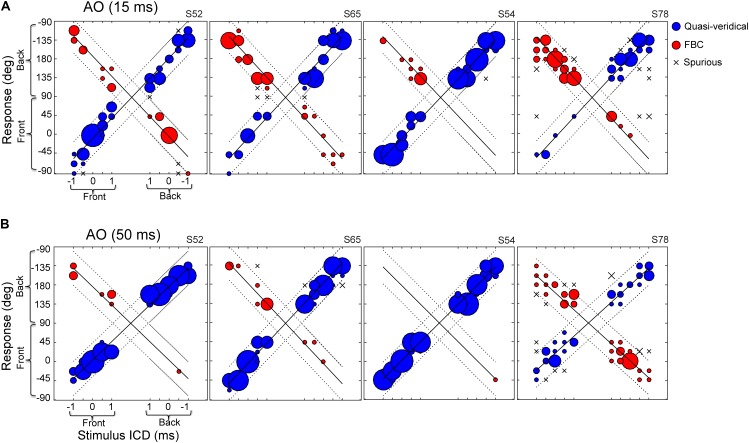
Stereo localization in front and rear space by four exemplar subjects in the AO condition. (A) Results for 15-ms noise burst. (B) Results for 50-ms noise burst. The left–right direction of a perceived sound source was altered by increasing/decreasing the inter-channel delay (ICD from –1 to 1 ms) between two loudspeaker signals. On the each panel, the left half shows front stimuli and the right half shows rear stimuli; the bottom half shows frontal response (–90 to 90°) and top half shows rear response (91 to –91°). See Figure 2 for the graphic layout of the setup. The size of a symbol is proportional to the percent response for a given stimulus. Regression lines were fit to the data using an iterative regression procedure (see section “Materials and Methods”). Localization responses were grouped into three categories: quasi-veridical, front–back confused, and spurious. The dotted lines on each plot bound the quasi-veridical (positive slope) and front–back confused (negative slope) response regions within ±40° of regression results.